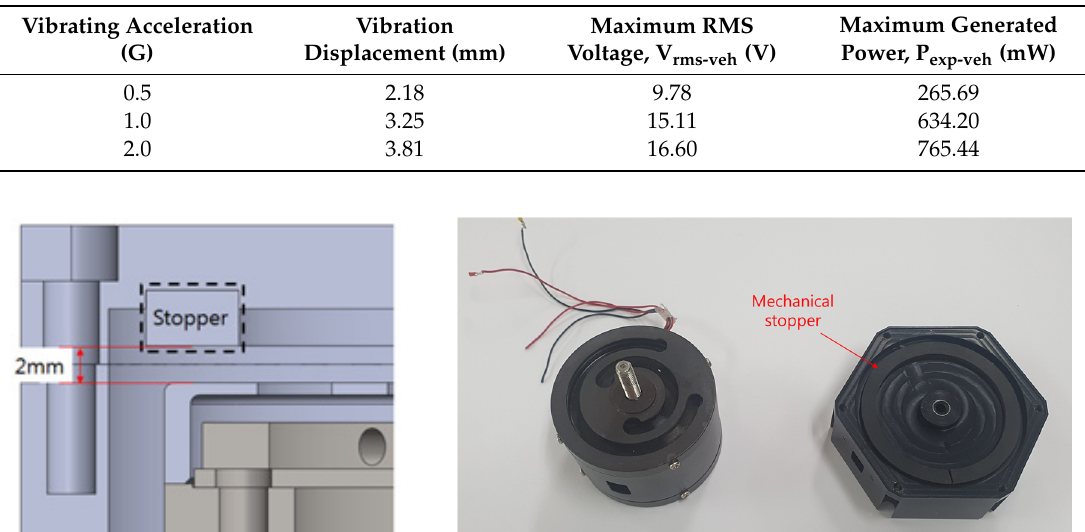
Table 1. The maximum values of the generated power with a 360 Ω load resistance (P exp-veh ) at one lower coil of the VEH device without the mechanical stopper. The maximum moving displacement of the spring was 4.0 mm.